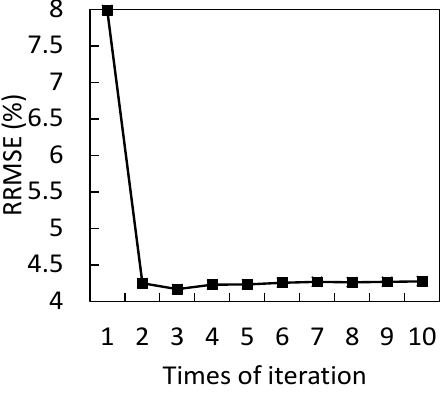
Figure 4. The variation in the average RRMSE in the SIF retrieved from the 2304 test datasets against the number of